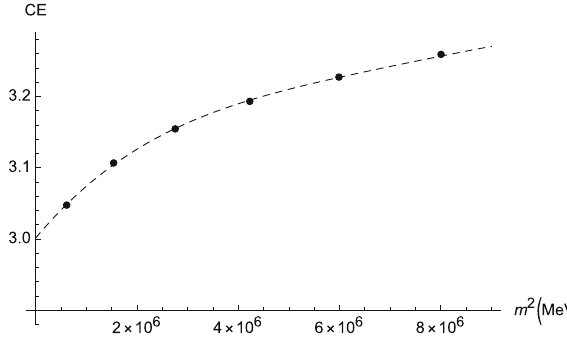
Fig. 3 CE for the ρ( 770 ) , f 2 ( 1270 ) , ω 3 ( 1670 ) , f 4 ( 2050 ) , ρ 5 ( 2350 ) , f 6 ( 2510 ) tensor mesons resonances, with respect to the mass spectra